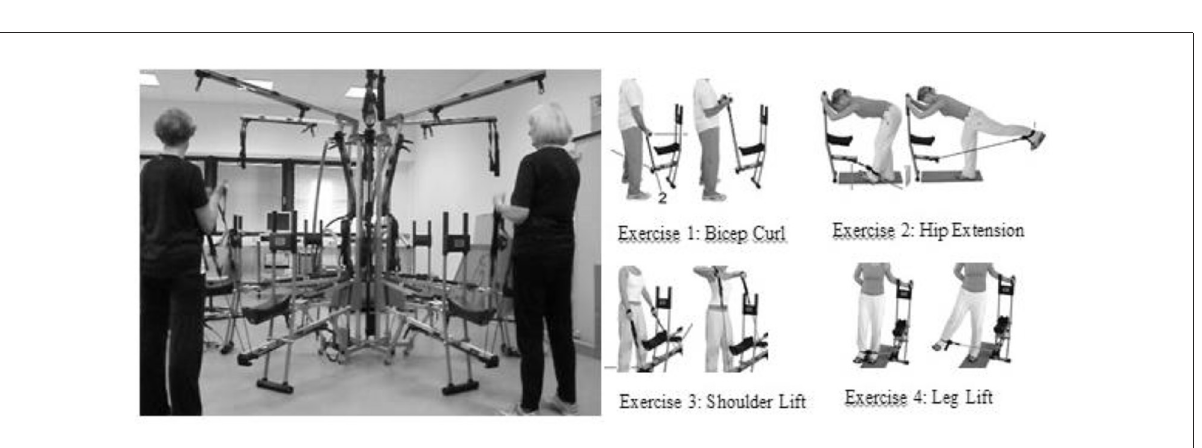
FIGURE2 Body-Spider ® equipped with sensors and the four exercises that were